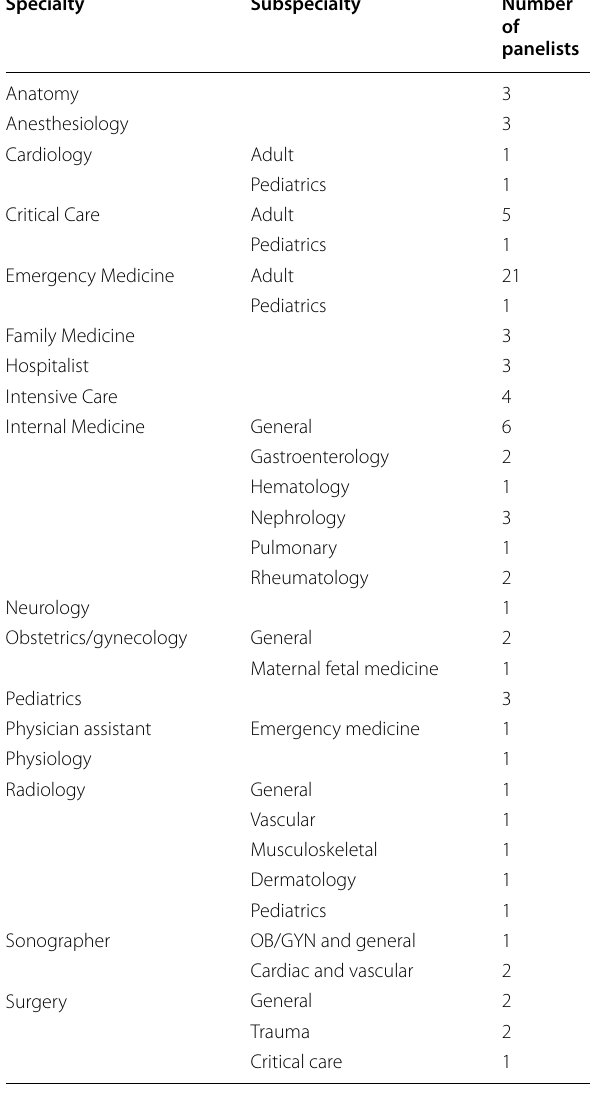
Table 1 Basic science and clinical specialties and subspecialties represented on the international consensus conference for